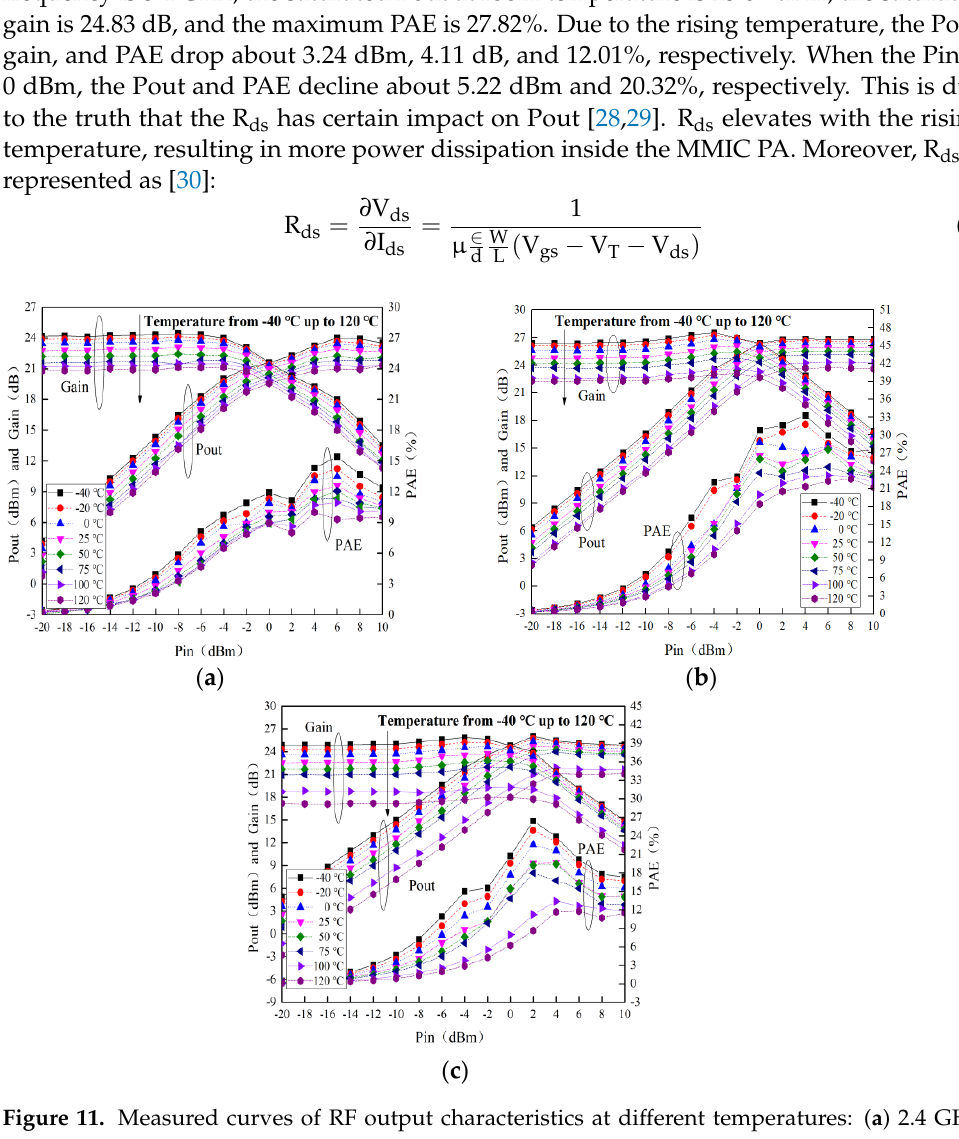
Figure 12. Measured curves of RF output characteristics with Pin of 0 dBm at different temperatures. According to Equation (4), as temperature rises, R (cid:2914)(cid:2929) increases due to the reduction in μ . Besides, gain and PAE are as follows [14,31]: Gain = Pout − Pin (5) PAE = (cid:2900)(cid:2919)(cid:2924)((cid:2891)(cid:2911)(cid:2919)(cid:2924)(cid:2879)(cid:2869)) (cid:2900) (cid:3162)(cid:3161) (6) where P dc is the DC power. It is clear to find from Equation (5) that as temperature rises, gain also decreases because of the reduction in μ . Meanwhile, P dc increases after thermal storage [31]. Thus, PAE reduces with the rising temperature according to Equation (6). In a word, when the temperature rises, the RF output characteristics for this MMIC PA de- grade severely due to the reduction in μ . It can be seen from the previous analysis [28,29] that R (cid:2914)(cid:2929) is the key factor to determine the temperature performance of RF output characteristics. The variation of R (cid:2914)(cid:2929) is closely